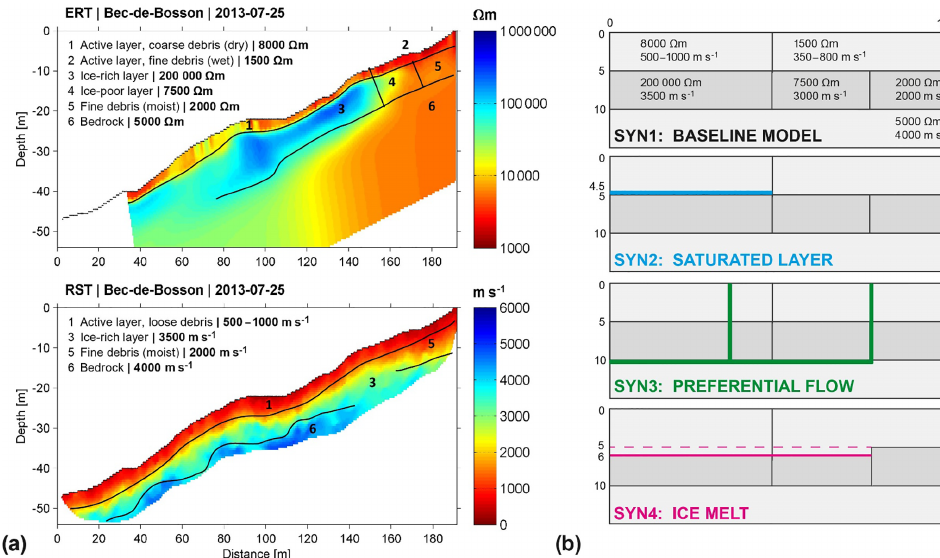
Figure 3. Creation of synthetic models based on inverted field data of the Becs de Bosson rock glacier: (a) inverted ERT and RST tomograms of 25 July 2013 with superposition of interpreted zones, (b) simplified synthetic baseline model (SYN1) based on the interpretation in (a) and different scenarios of hydrological processes (SYN2 to